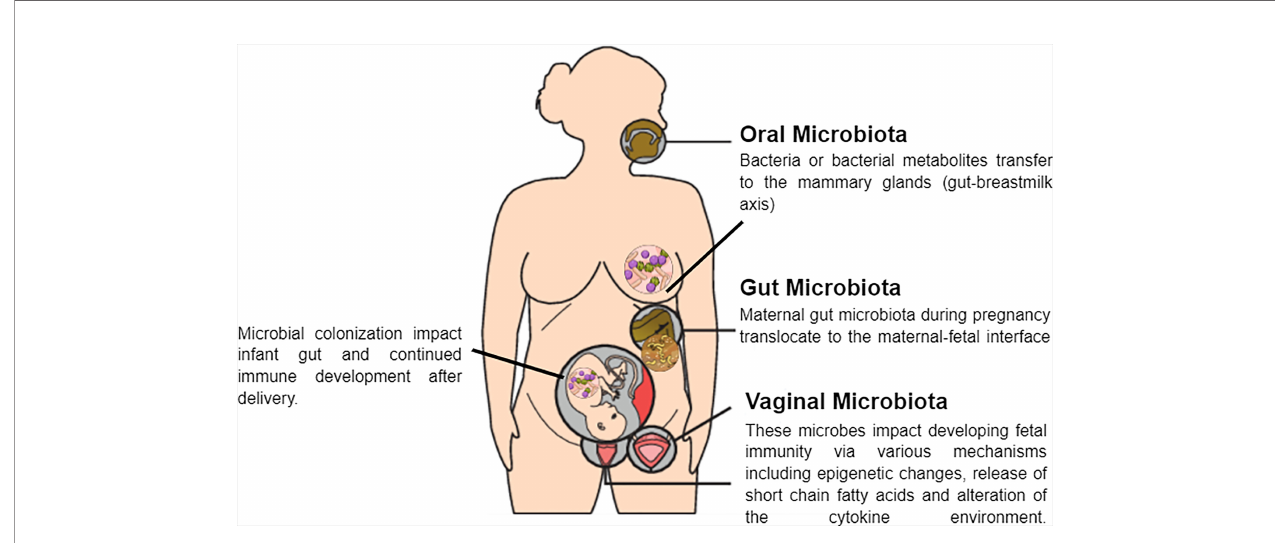
FIGURE 2 | Potential mechanisms of crosstalk between maternal microbiota and the